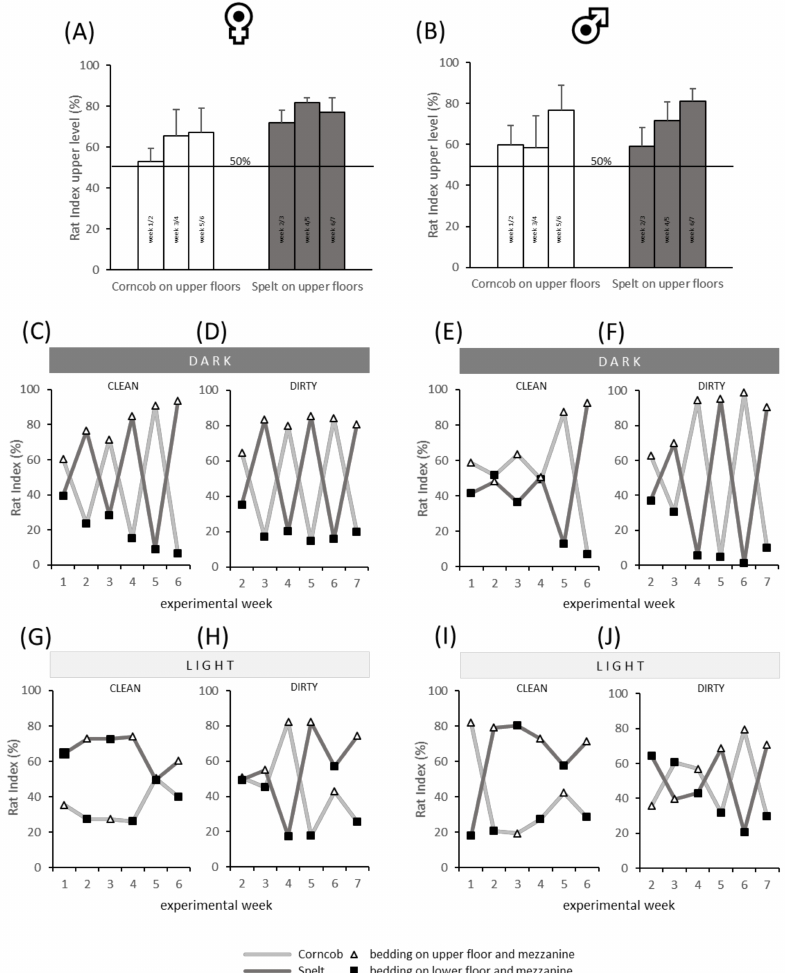
Figure 2. Spatial pattern in the preference cages in the context of different types of beddings and light conditions for female (left) and male (right) rats, illustrated by the rat index (RI). ( A , B ) Mean RI (+SEM) for the upper level only, summarizing per column the four different conditions (light/clean, light/dirty, dark/clean, and dark/dirty). Experimental weeks are referring to those in Table 2; ( C – F ) RI in dark conditions under clean and dirty conditions, respectively, for females ( C , D ) and males ( E , F ). Independent of bedding, rats demonstrate descriptively higher preferences for the upper compartment; ( G – J ) RI in light conditions under clean and dirty conditions, respectively, for females ( G , H ) and males ( I , J ). Rats demonstrate descriptively higher preferences for the upper compartment. When looking at clean versus dirty conditions, the illustration indicates a preference for clean spelt under light conditions. Light grey line, corncob; dark grey line, spelt bedding substrate; white triangle, measurement of the upper floor and mezzanine; black square, measurement of the lower floor and mezzanine; each dot represents 1 h